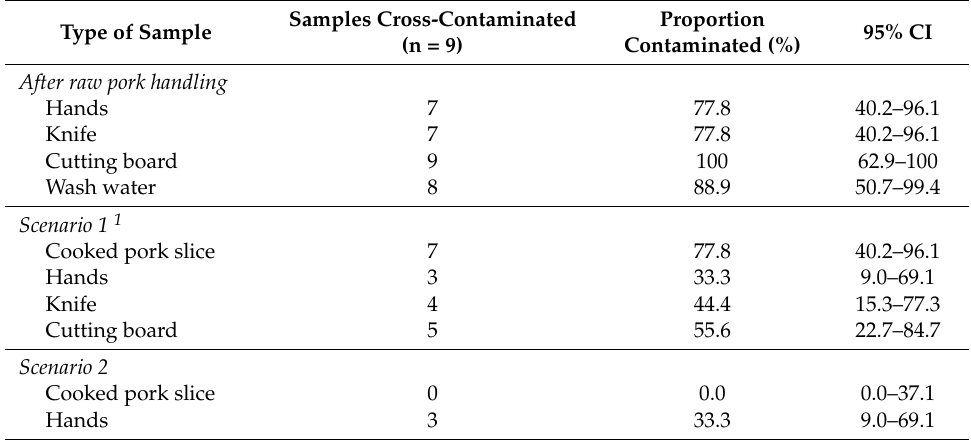
Table 4. Proportions of cooked pork slice, hands, equipment and wash water on which cross- contamination with Salmonella occurred during the experiments.